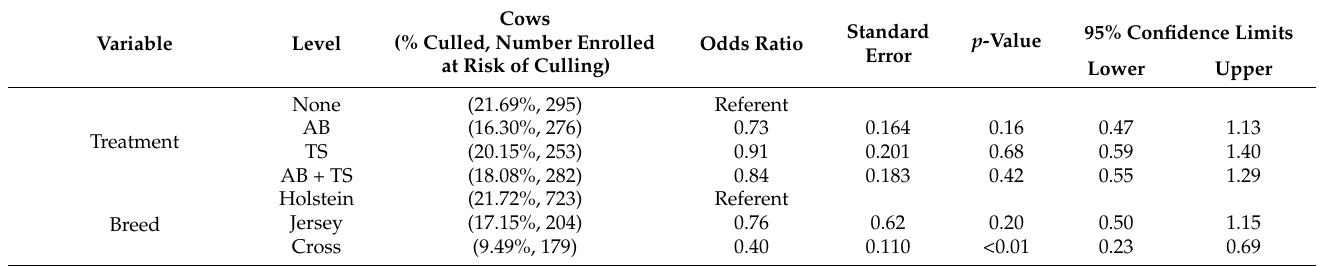
Table 6. Logistic regression model predicting total culling (dry period + after calving until 150